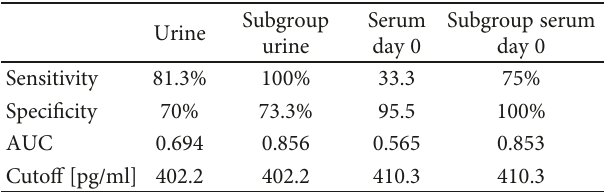
Figure 3: Accuracy of the I-FABP test and its dependence on the interval to the triggering ischemic event, based on all d0 serum and urine samples. Among tests performed later than 48 hours after the event, the number of false negative results increased. Table 3: Key fi gures of the diagnostic